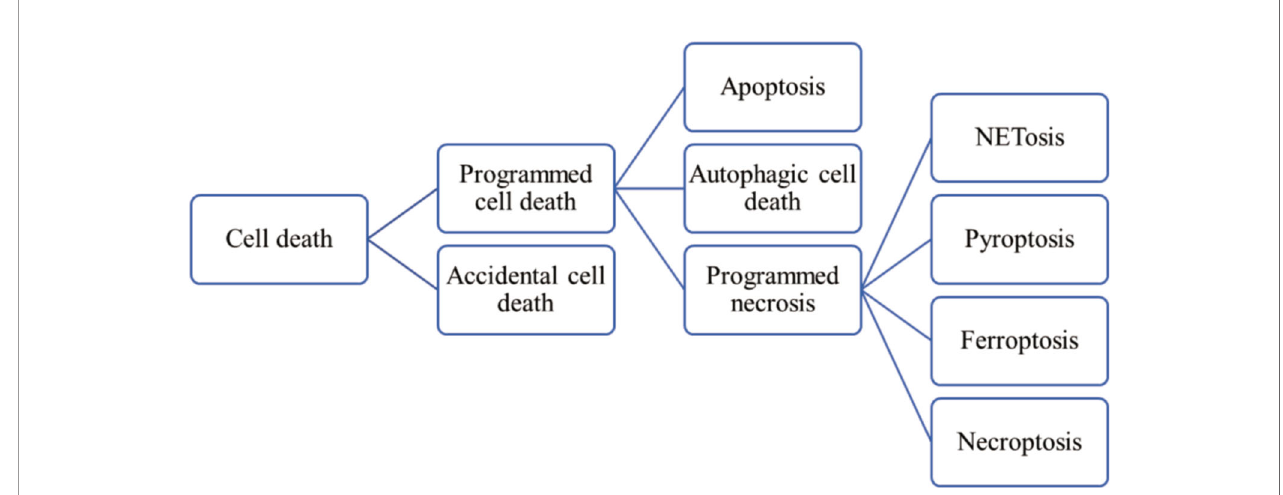
FIGURE 1 | Classi fi cation of cell